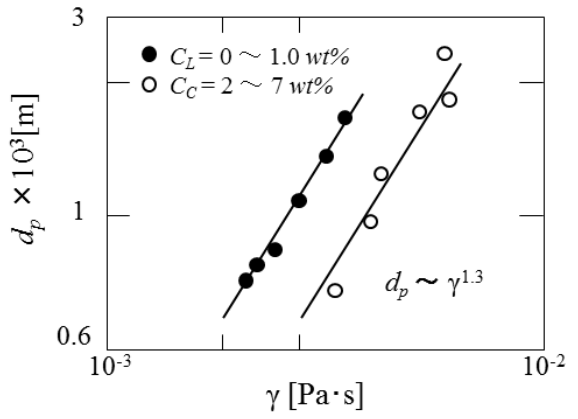
Figure 9. Dependence of mean diameter on interfacial